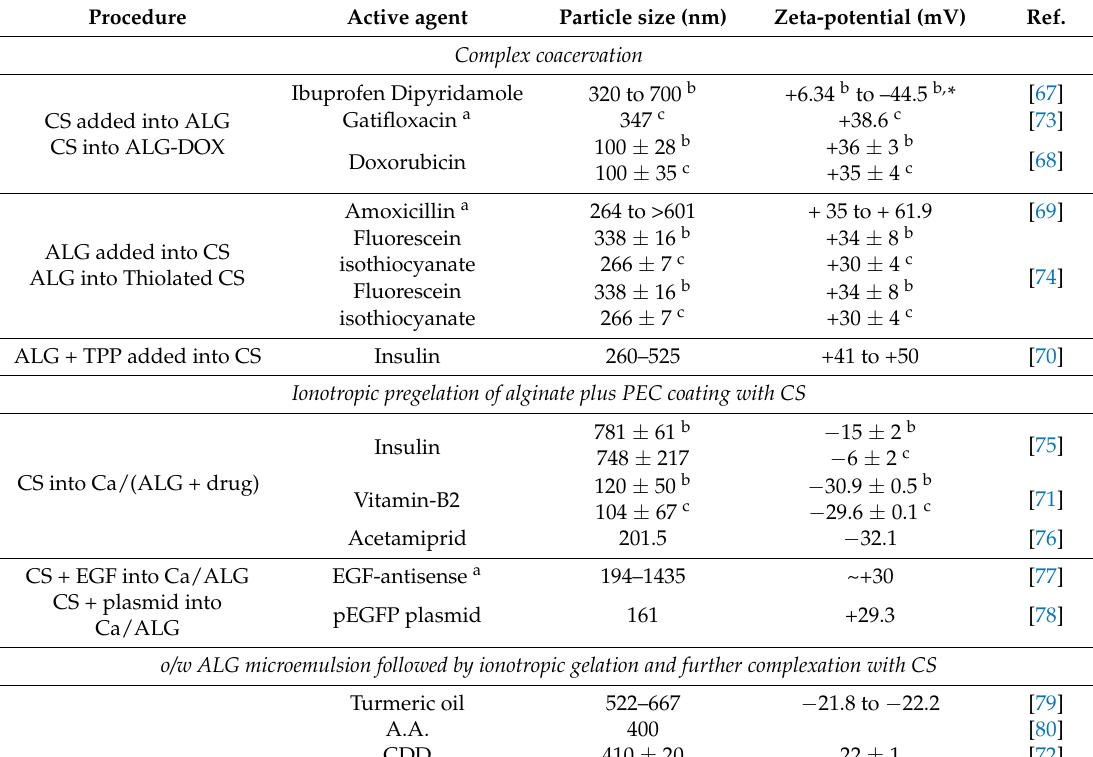
Table 1. Chitosan-Alginate PEC nanoparticles. The intervals shown generally indicate extreme values obtained under different preparation